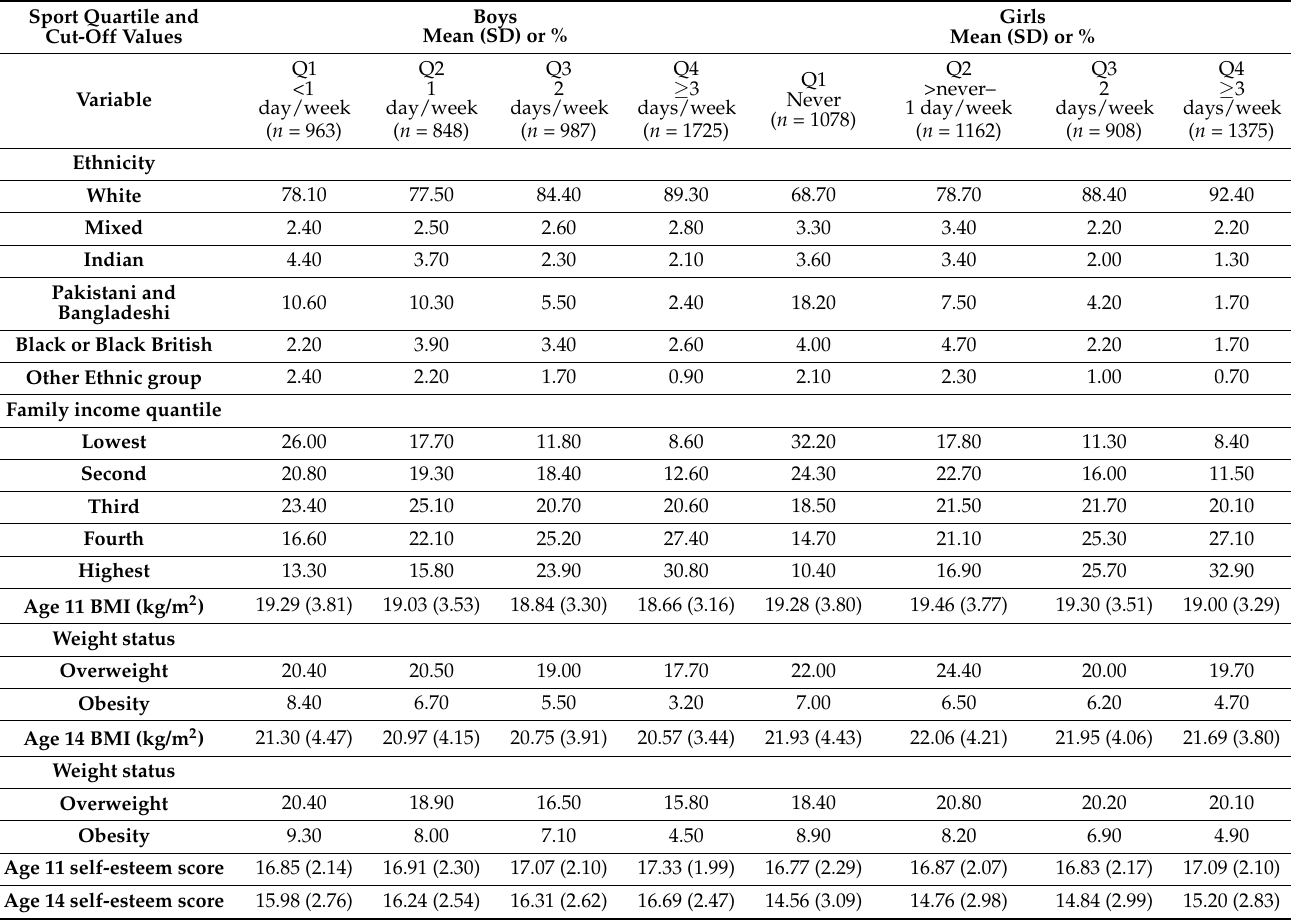
Table 1. Descriptive characteristics of